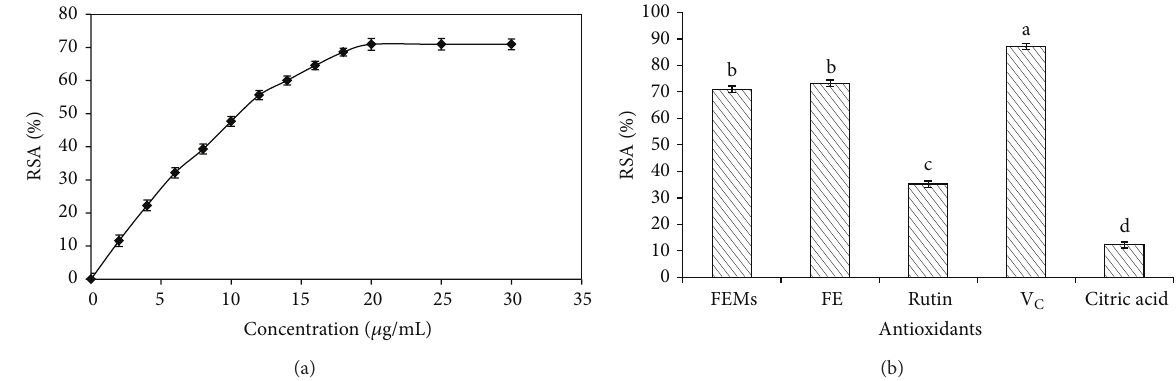
Figure 3: DPPH scavenging radical activity of (a) different concentrations of FEMs (b) 20 𝜇 g/mL of FEMs, FE, rutin, V C , and citric acid. Data was shown as mean ± SD ( 𝑛 = 3 ).